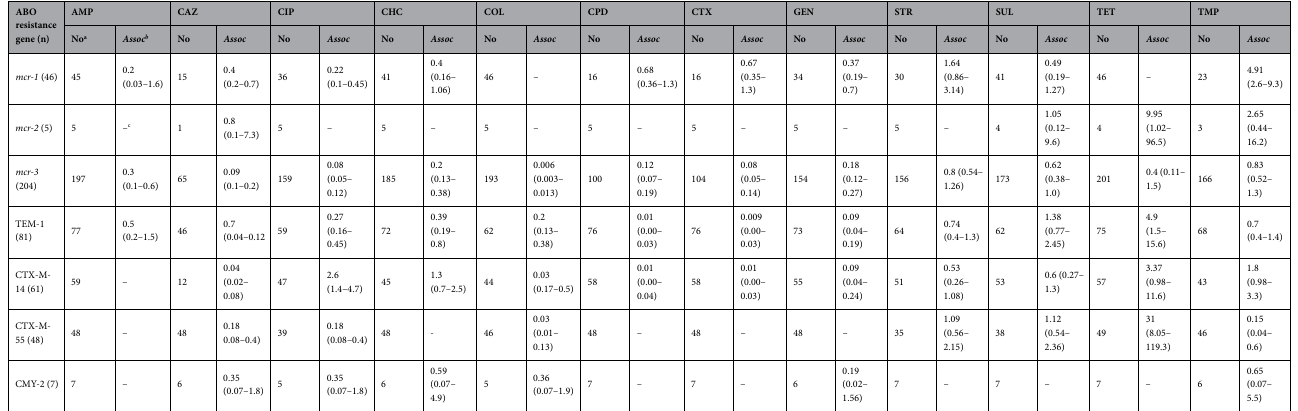
Table 6. Associations between resistance phenotype and genotype in Escherichia coli from healthy pigs and sick pigs (n = 454) in Thailand between 2007 and 2018. a No., number of isolates resistant to corresponding antimicrobial agents and carrying the relevance resistance genes. b Odds ratio (OR) for significant associations between antimicrobial resistance gene and antimicrobial resistance phenotype (95% confidence interval in parenthesis). OR > 1 represents positive associations, and OR < 1 represents negative associations. c No significant associations ( P ≥ 0.05). AMP ampicillin, CAZ ceftazidime, CIP ciprofloxacin, CHC chloramphenicol, COL colistin, CPD cefpodoxime, CTX cefotaxime, GEN gentamicin, STP streptomycin, SUL sulfamethoxazole, TET tetracycline, TMP